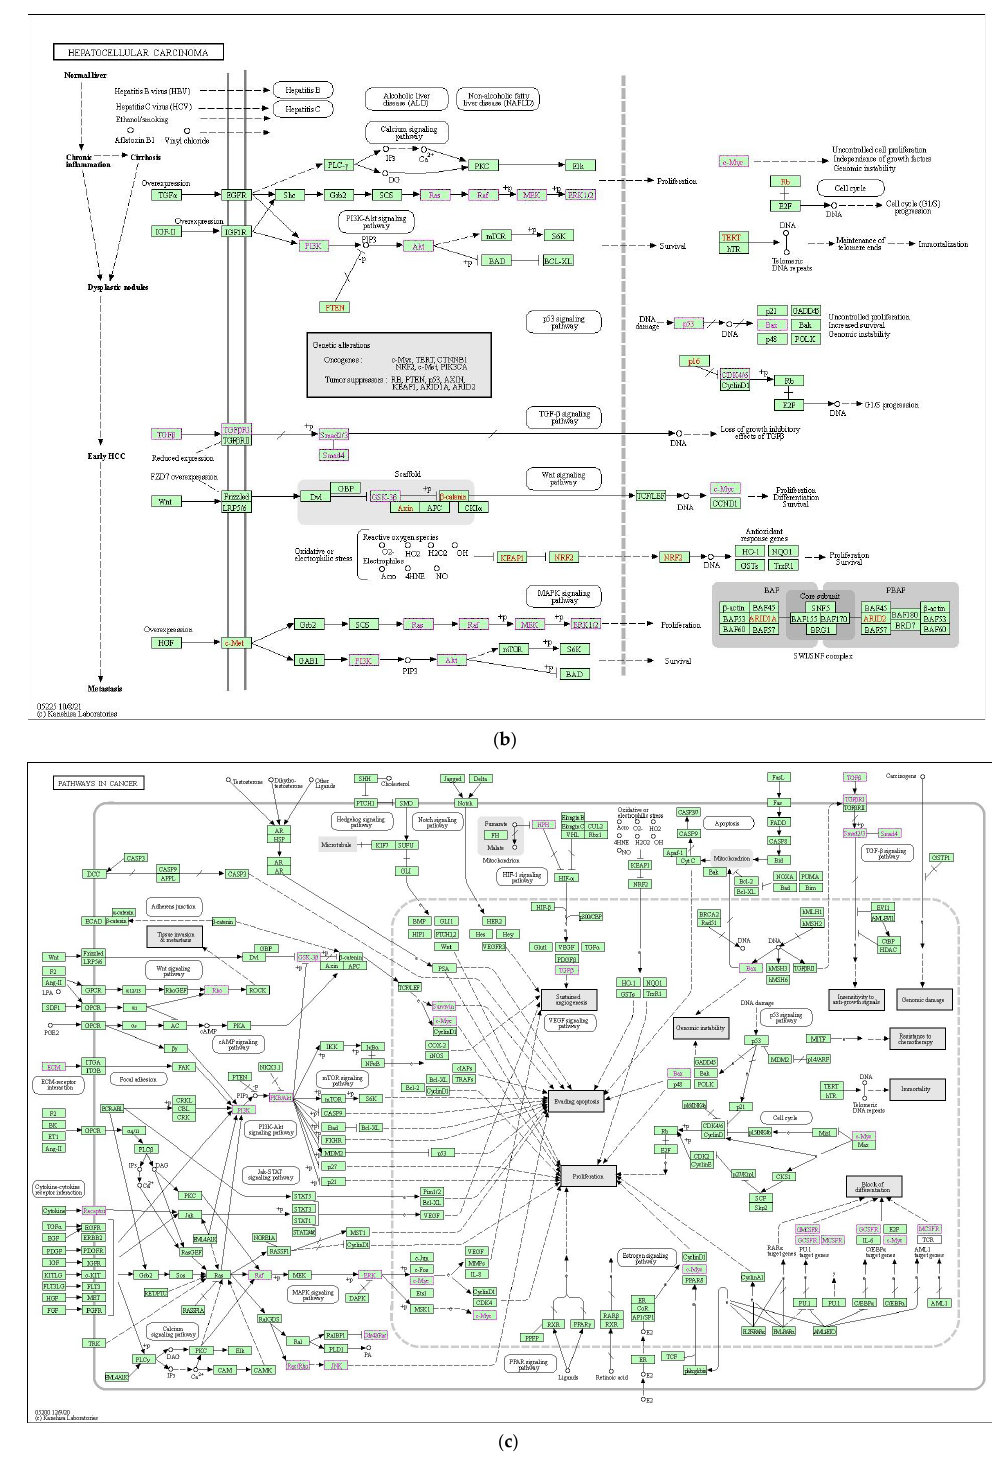
Figure 4. KEGG pathway analysis describing the presence of miR-122 interactors in different pathways; ( a ) DAVID KEGG colorectal cancer pathway analysis; (genes involved in the colorectal cancer pathway (red star) are target interactors of miR-122). ( b ) DAVID KEGG hepatocellular car- cinoma pathway analysis; (miR-122 interactors involved in hepatocellular carcinoma are labelled in purple and red; purple: enhancers; red: inhibitors). ( c ) DAVID KEGG pathways in cancer analysis; (miR-122 interactors involved in major cancer-associated pathways are labelled in purple). The involvement of transcription factors in controlling the interaction of miR-122-associated proteins was analyzed using the Enrichr tool. An adjusted p -value cut-off of 0.01–0.1 was used to filter the top 10 TF interactors and their possible interac- tivity was assessed. Through factor enrichment analysis, the interaction of the gene set with the top 10 transcription factors was examined, out of which CEBPB and NCOR1 had the highest number of edges (Figure S2). The transcription factors were scrutinized based on the higher number of interactions with miR-122 interactors. SMAD3, SMAD4, and CEBPB came up as key transcription factors regulating cancer progression at the late adenoma stage (Figure 4a). The tumor suppressor TFs SMAD3 and SMAD4 are involved in the TGF-ß signaling pathway regulation, and loss of which could lead to deregulation of apoptosis in the cell (Figure 4a; Table S3). To construct and analyze the interactome, the STRING database was used to study the interaction of the transcription factors with each other (Figure 5; Table S3). The closed interactome exhibited the mutual influence of the transcription factors.